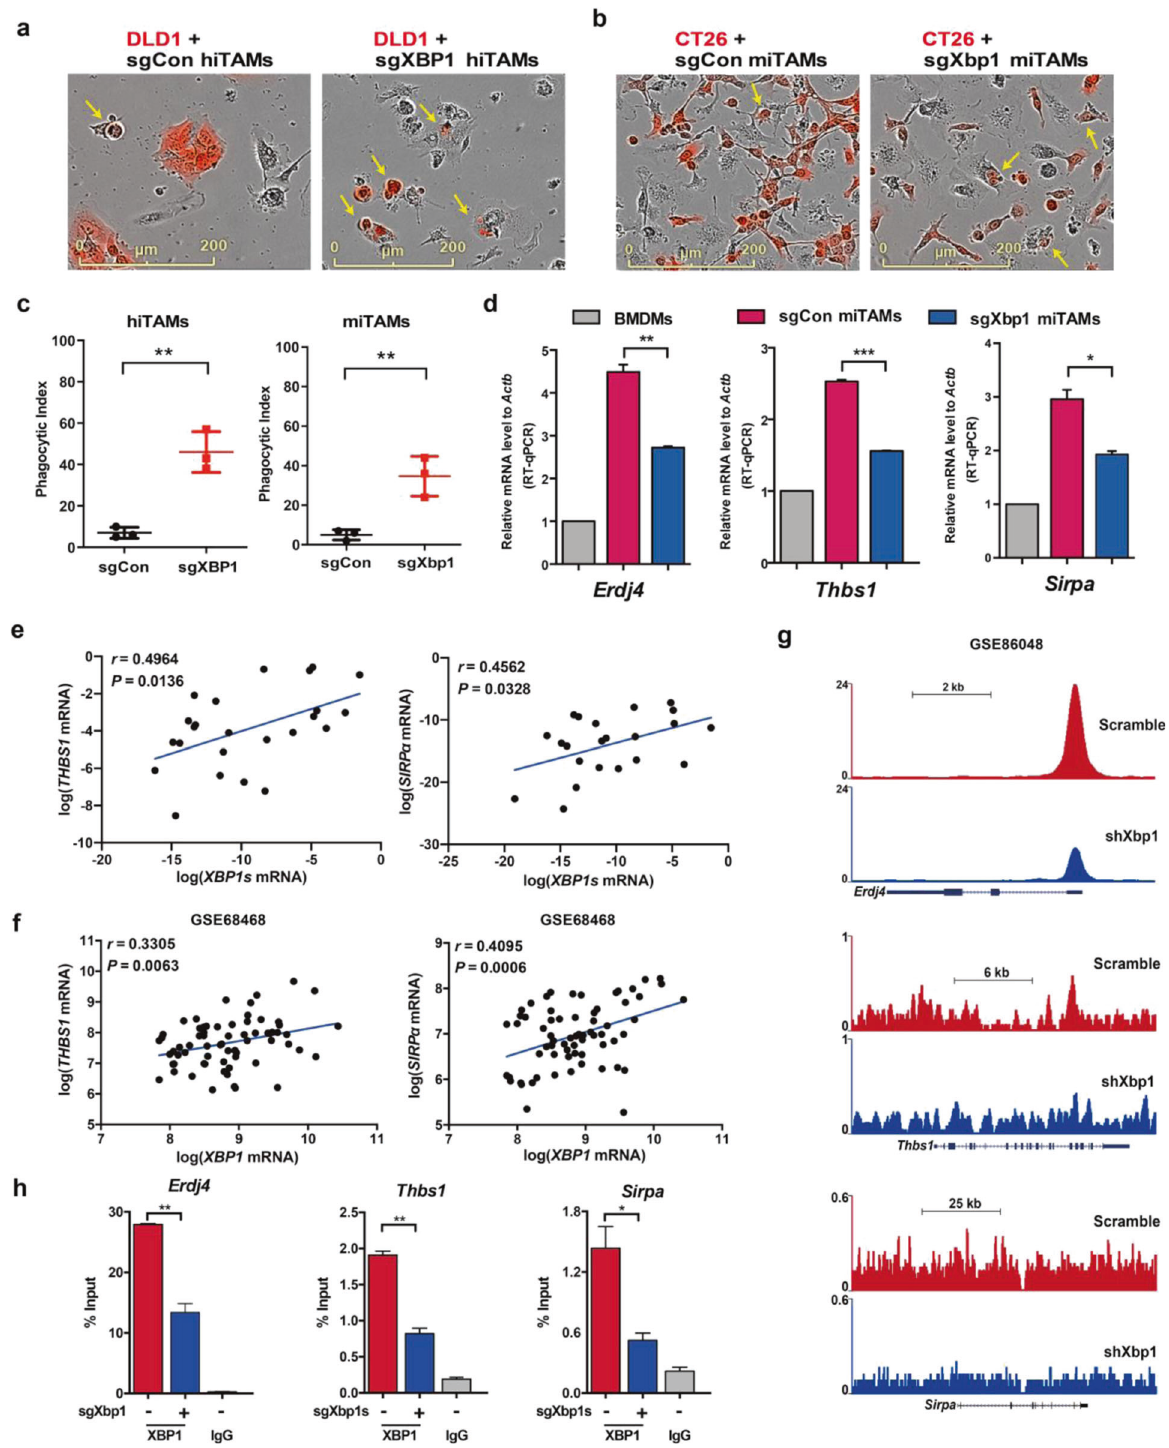
F4/80, CD206, and XBP1 in colon sections from AAV2-sgCon and AAV2-sgXbp1 AOM-DSS mice. We detected the expression of XBP1 in colorectal cancer tissue from mice model treateds with AAV2-sgXbp1, as shown in Supplementary Fig. S7a – d; the expression of XBP1 decreased in F4/80 + macrophages but not in epithelium cells. The result indicated that the anti-tumor function was a result of knocking out XBP1 from TAMs but not from tumor cells. Conditional deletion of XBP1 in TAMs signi fi cantly inhibited tumor formation in AOM-DSS mouse model